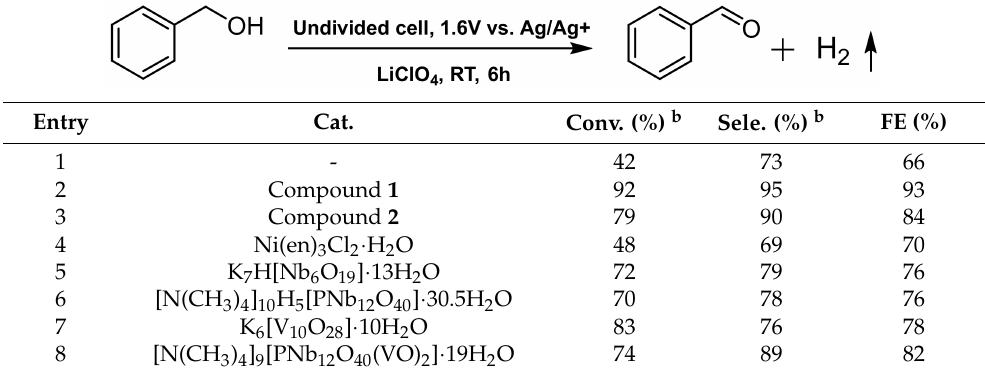
Entry Cat. Conv. (%) b Sele. (%) b FE